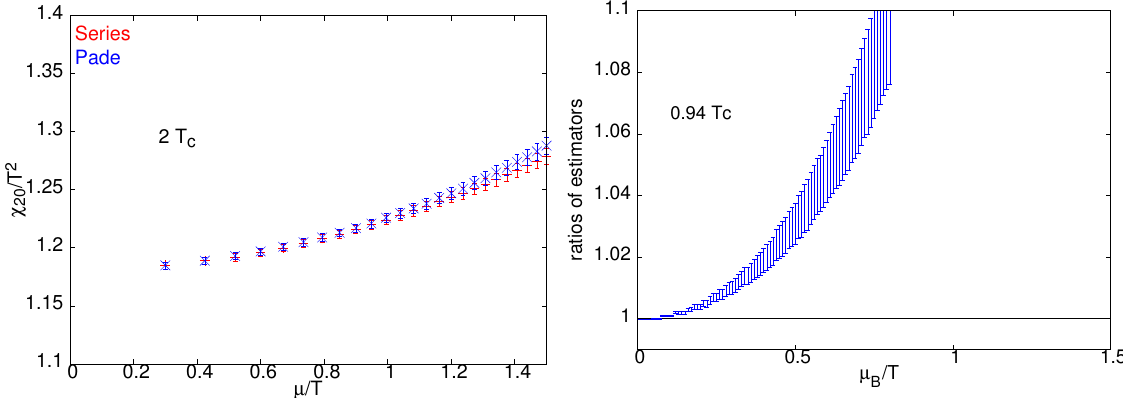
Figure 3. ( left ) Comparison of the Pade estimator for χ 20 with the series-summed one at 2 T c . ( right ) Ratio of the Pade estimator of χ 2